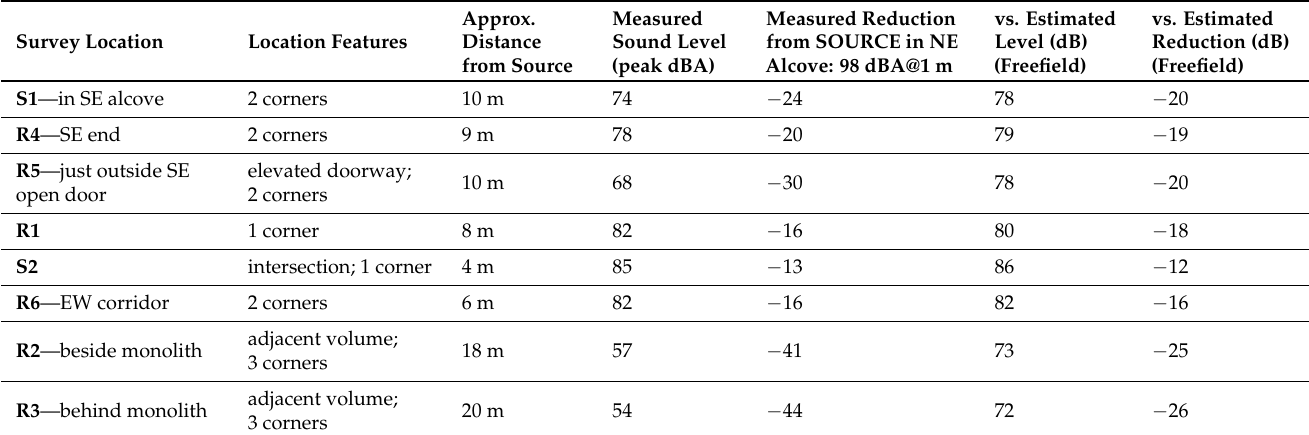
Table 4. Sound-level measures, dB-SPL (A-weighted), Lanzón Gallery, Chavín, from directional broadband noise source 98 dBA@1 m. Survey map Figure 6 (above) shows spatial